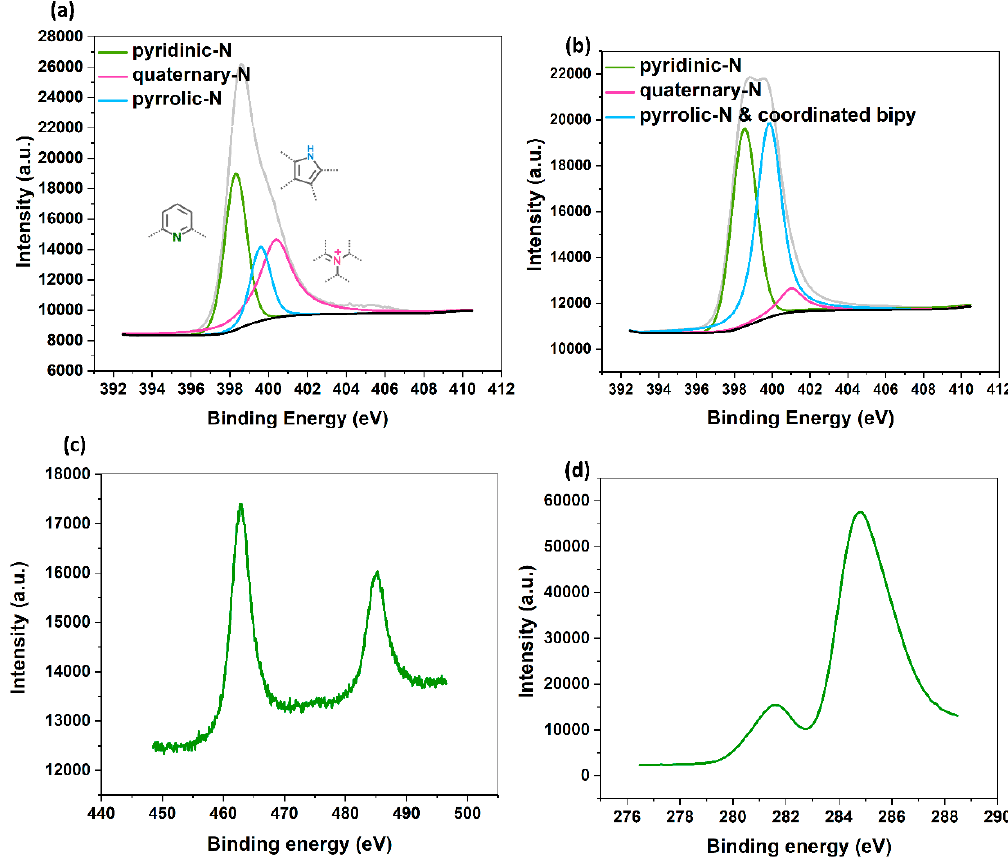
Figure 3. Structural characterization of bipy-CTF and Ru III @bipy-CTF materials. ( a ) N 1S XPS spectrum of the bipy-CTF. ( b ) N 1s XPS spectrum of the Ru III @bipy-CTF. ( c ) Ru 3p XPS spectrum of the Ru III @bipy-CTF. ( d ) Ru 3d XPS spectrum of the Ru III @bipy-CTF.